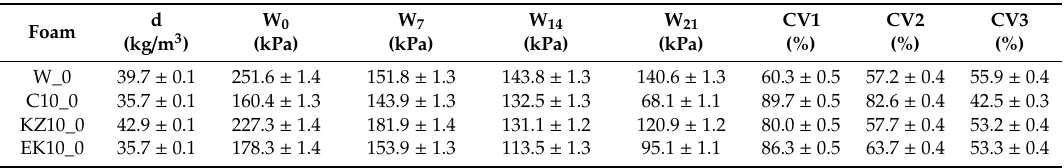
Table 5. Density (d), compressive strength (W), and compressive strength ratio (CV): W 0 —measured before conditioning, W 7 —mesaured after 7-days conditioning, W 14 —mesaured after 14-days conditioning, W 21 —mesaured after 21-day conditioning.